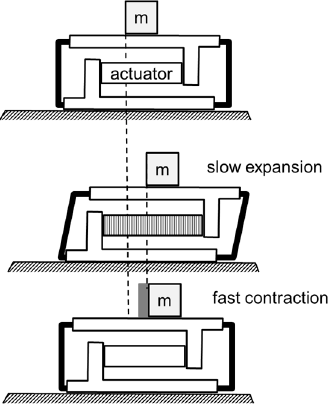
Figure 3. Inertia-drive piezoelectric motor proposed by Pohl in 1986 [29].